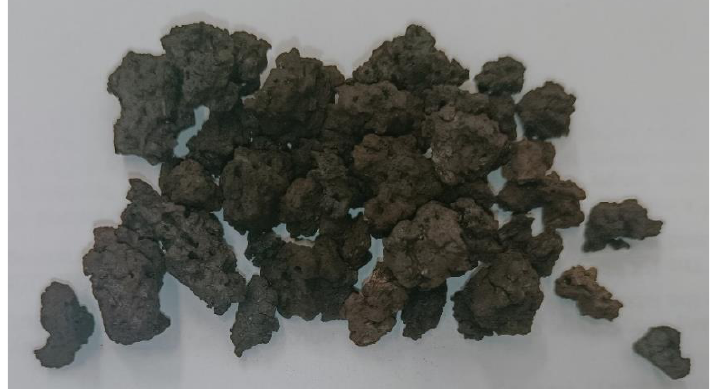
Figure 1. Image of biochar obtained by pyrolysis of a sludge – margin mixture at 500 °C .